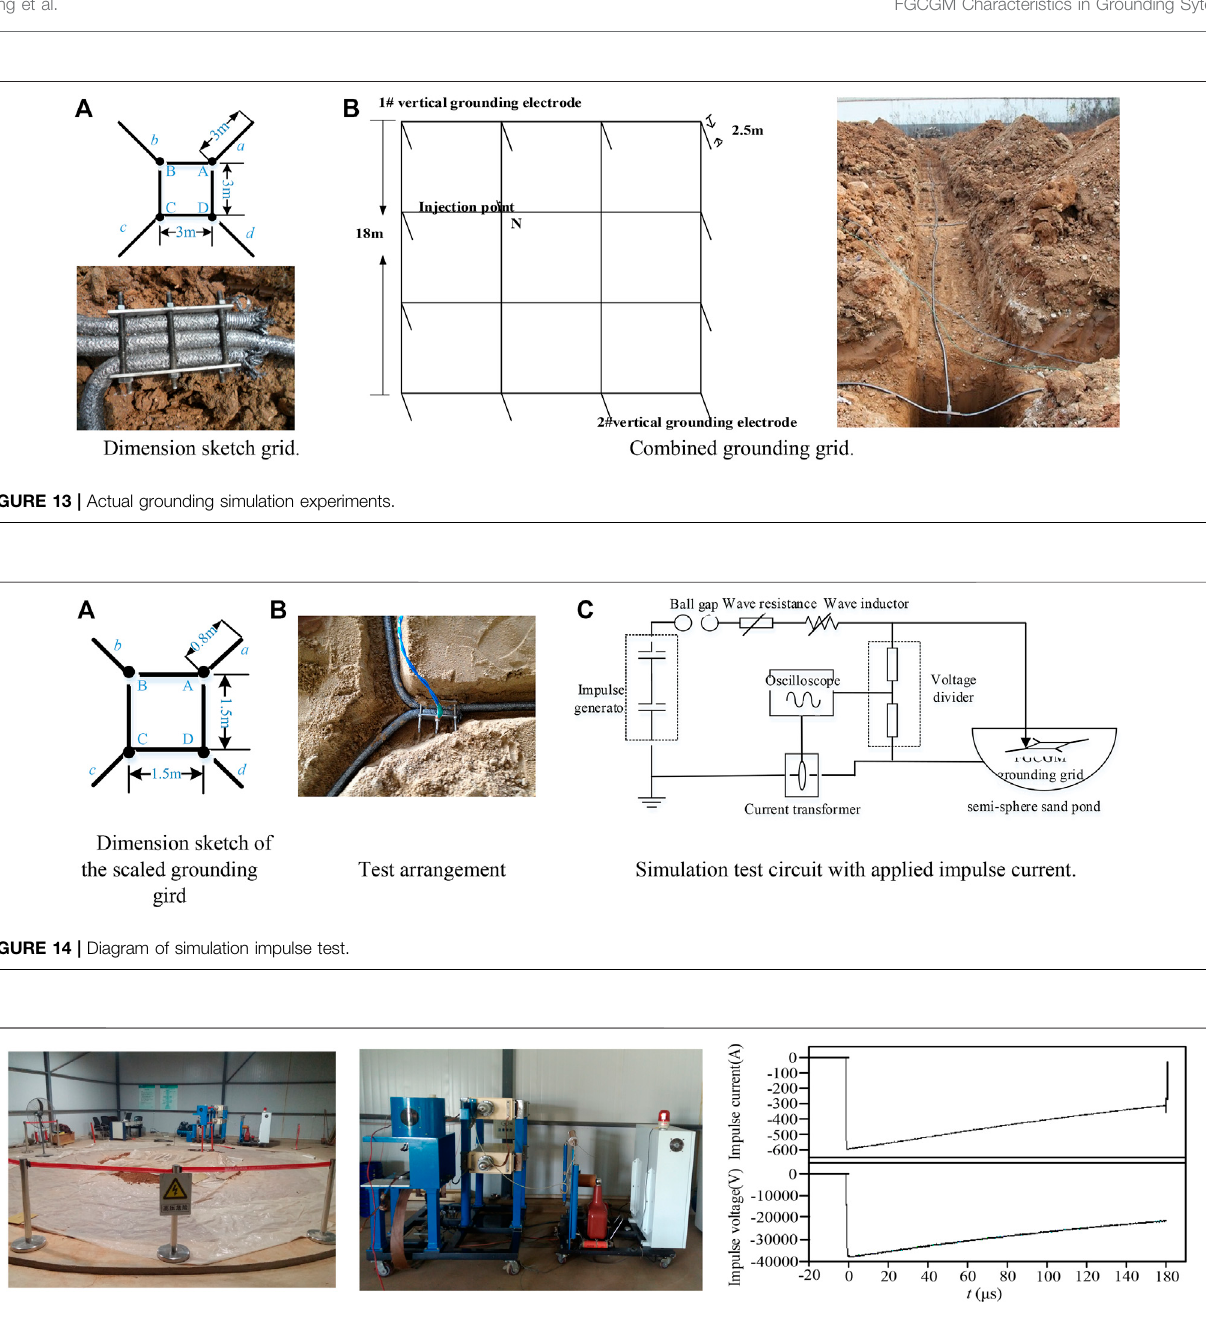
FIGURE 15 | Measured waveform of impulse current and impulse